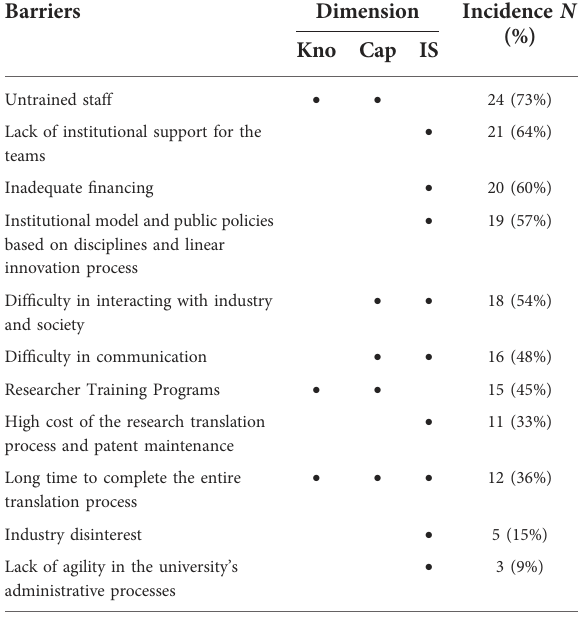
TABLE 5 Incidence of factors indicated as determinants for favoring the implementation of translational research, from the dimension of